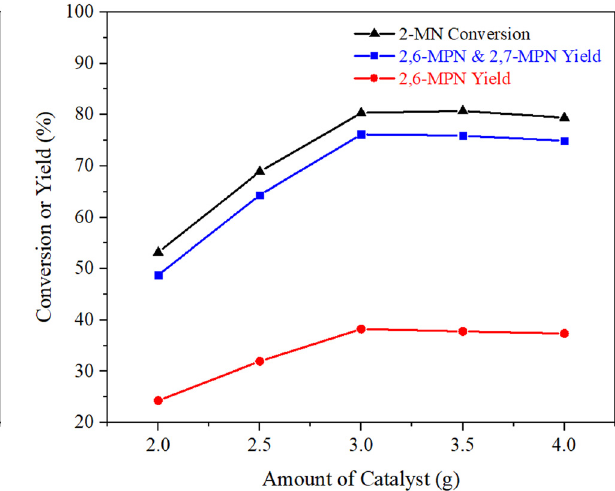
Figure 9: E ff ect of calcination time on the performance of 2 - MN pro - pionyl catalyzed by AlCl 3 /H β . Reaction conditions: n ( 2 - MN ) : n ( PA ) = 1:1.8, TS 10g, AlCl 3 /H β ( AlCl 3 3g · L − 1 , re fl ux for 9h and calcination at 550°C ) 3g, 190°C, 10h.